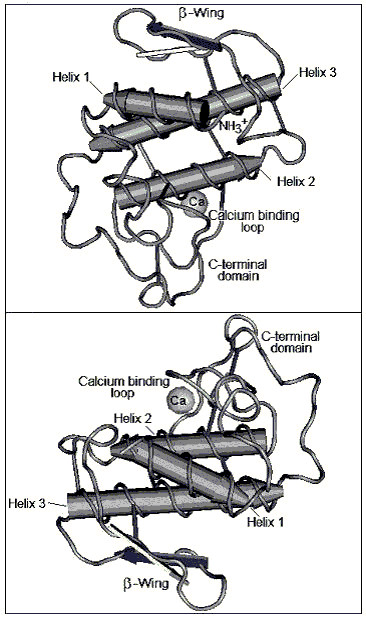
The three dimensional model of PLA2 from Crotalus durissus cascavella venom was determined by comparative homology modelling using BLASTP in Protein Data Bank. The model shows the β-wing, α-helix, calcium binding loop, and C-terminal loop.